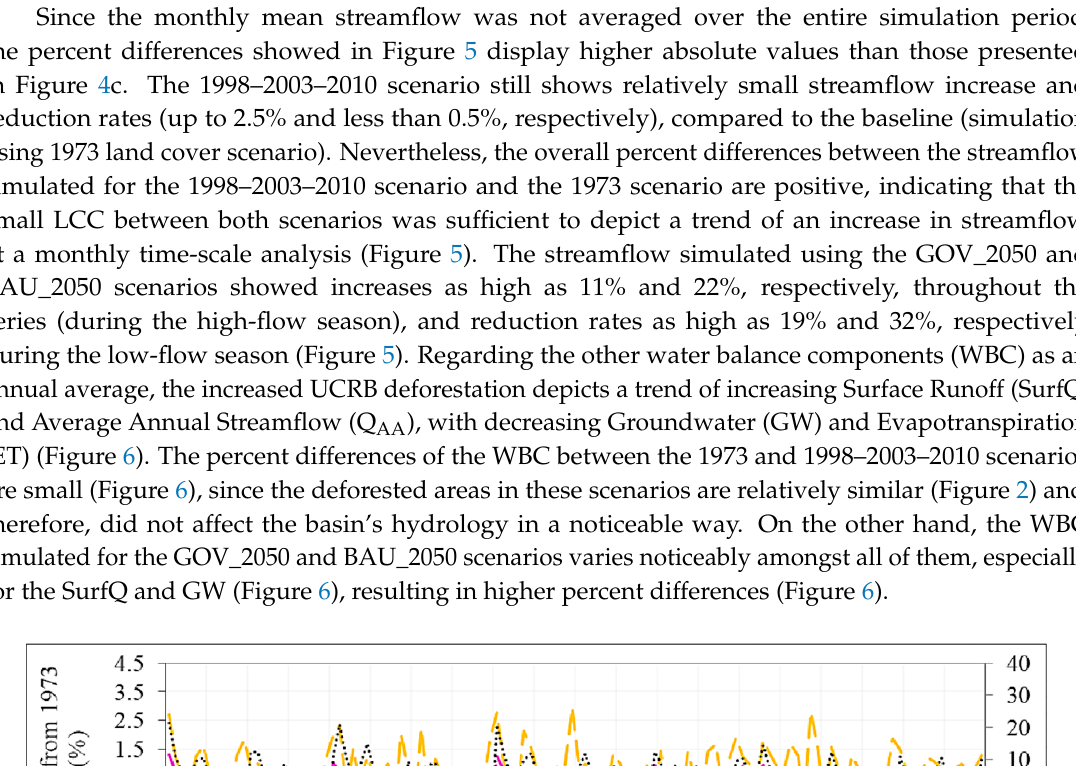
Figure 6. Annual average of the WBC in the UCRB and percent differences in relation to simulations with the 1973 scenario (baseline). SurfQ stands for surface runoff, GW is the groundwater, ET is the evapotranspiration, and Q AA is the average annual streamflow.